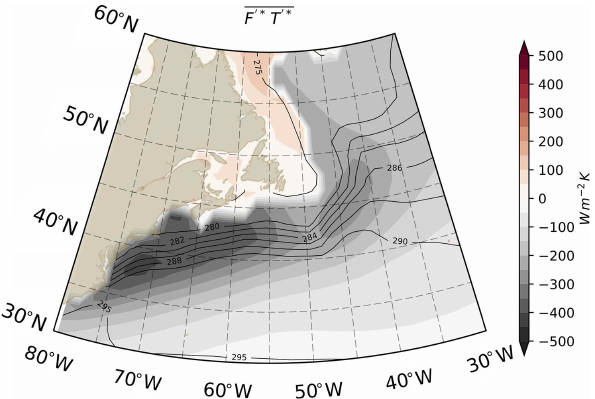
Figure 4. Wintertime (DJF, 1979–2019) mean of the product be- tween time–space anomalies in F and T over the spatial domain selected for our study (shading) and wintertime SST climatology (contours, every 2K from 280 to 290K, every 5K